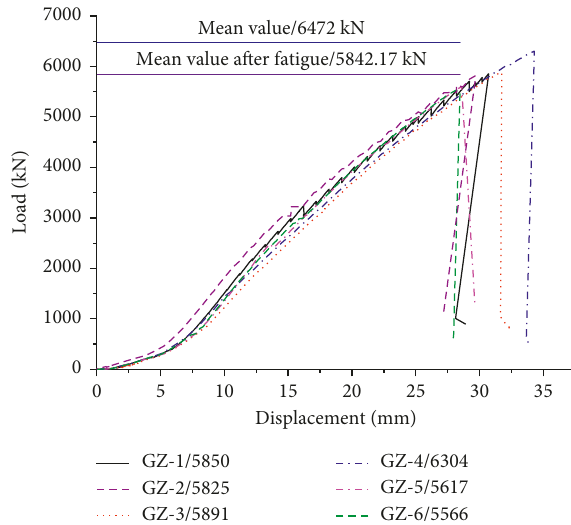
Figure 9: Analysis of ultimate bearing capacity after fatigue.